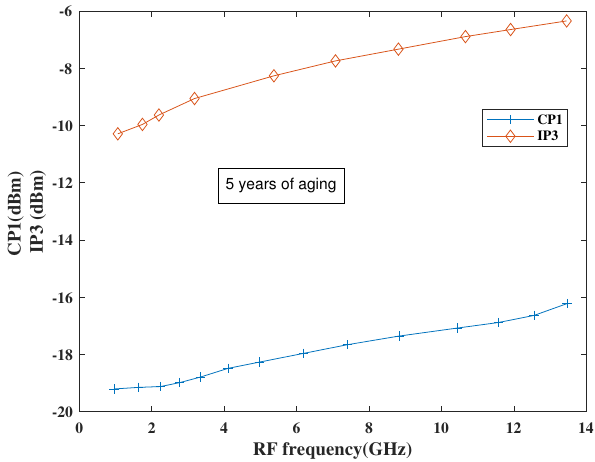
Figure 21. CP1 and IP3 degradation